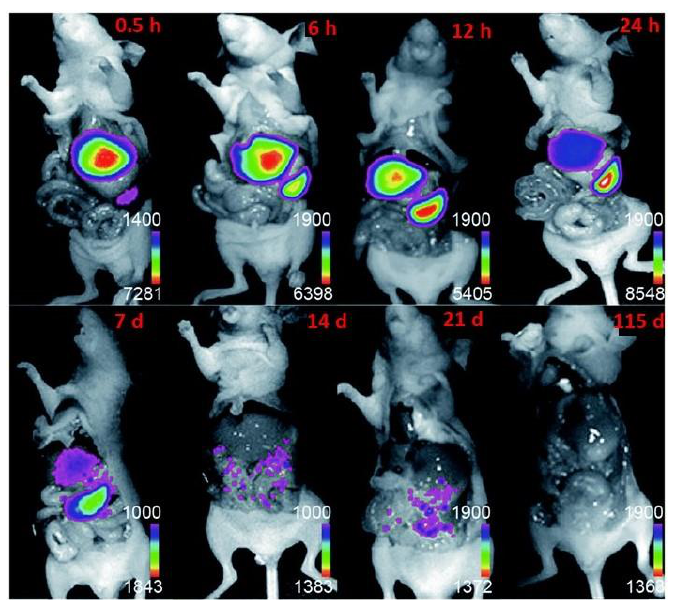
Figure 11. Upconversion imaging of mice with injection of PAA-coated NaYF 4 :Tm 3+ /Yb 3+ UCNPs at various time points (Reproduced from Ref. [94], Copyright (2010), with permission from